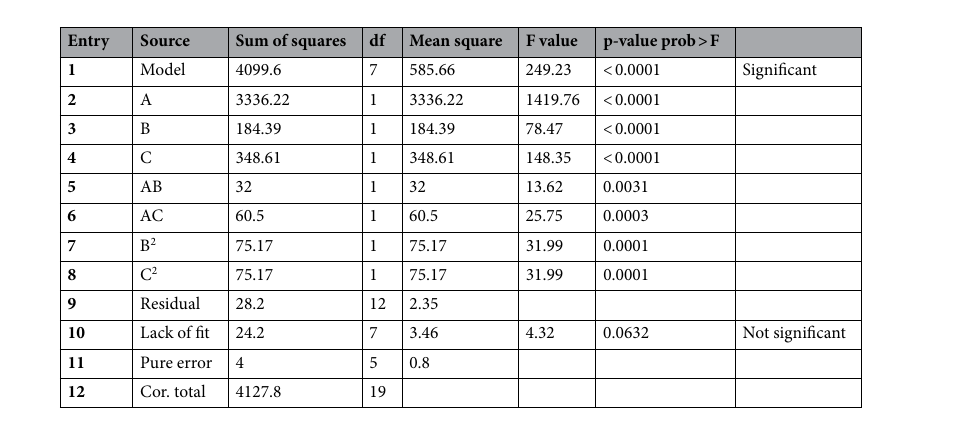
Table 5. ANOVA output data for suggested first-order